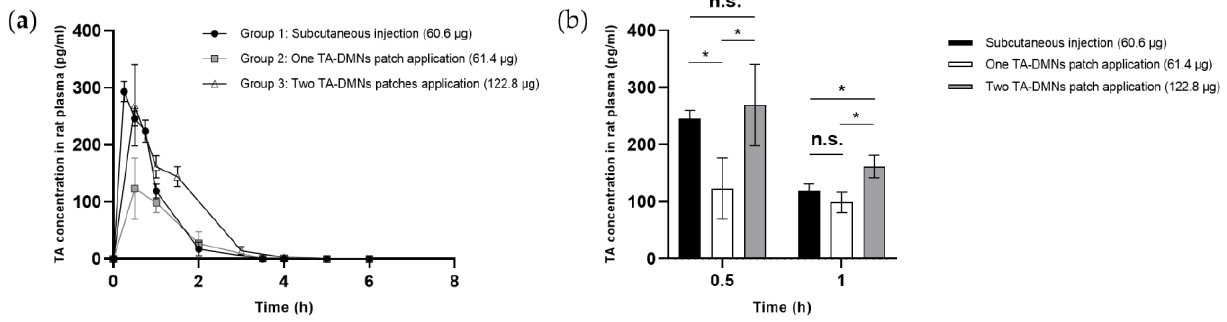
Figure 5. Pharmacokinetic profiles of TA in rat plasma after TA-DMN patch applications. ( a ) TA concentrations in the plasma samples of the rats in three experimental groups administered with TA in three different methods: (1) TA 60.6 µ g dose subcutaneous injection (SC); (2) TA 61.4 µ g dose TA-DMN patch application; and (3) TA 122.8 µ g dose TA-DMN patch application. ( b ) Bar graph showing TA concentrations in the rat plasma collected 0.5 and 1 h after the administration of TA. Data represent the average ± standard deviation, and n = 3 for all groups. Statistical significance was set to * p < 0.05. n.s. means not significant. Table 1. Pharmacokinetic profiles of teriparatide acetate (TA)-administered rats.